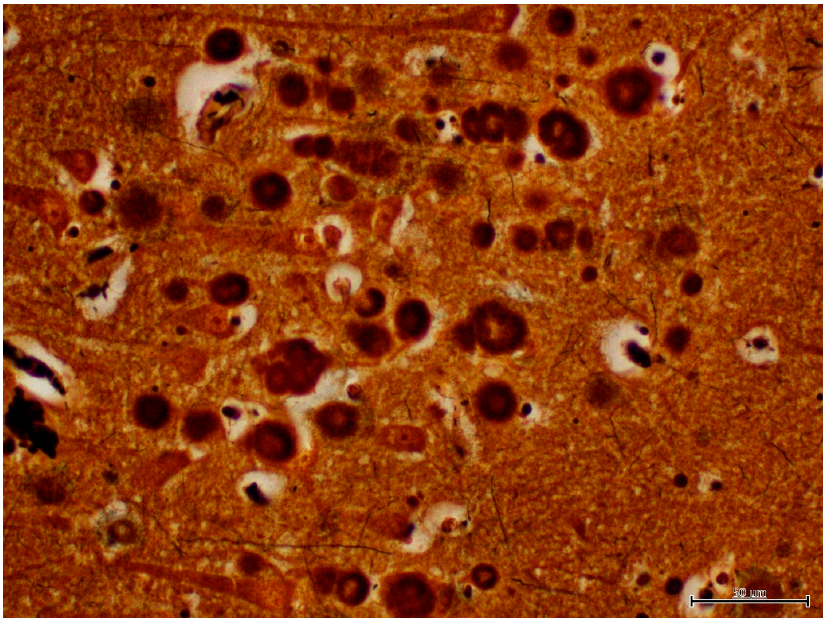
Figure 5. Bielschowsky’s silver-stained section of the hippocampus of the same moose showing dark-stained polyglucosan (Lafora) bodies. Ultrastructurally, the PGB inclusions in CA1, CA2, and CA3 of the hippocampus were non-membrane-bound electron-dense bodies (Figure 6) composed of accumulations of osmophilic orderly branching filamentous materials (Figure 7) with scattered dense ag- gregates of glycogen-like material at the peripheries of some inclusions (data not shown).